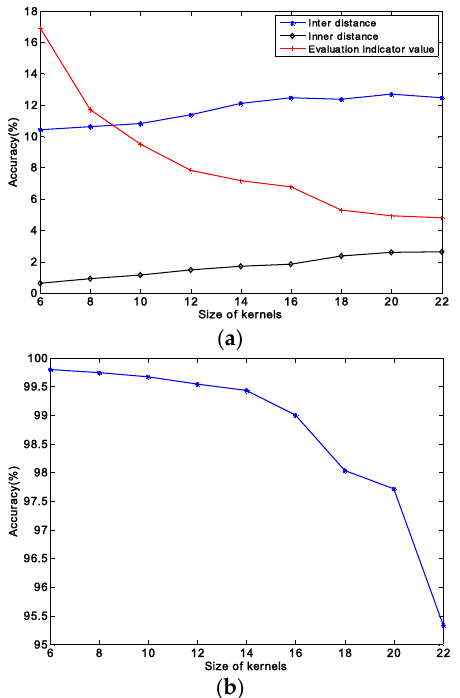
Figure 8. The classification accuracy influence with the kernel size. ( a ) the evaluation indicator value, the inter distance and inner distance with different kernel sizes on Dataset 1; ( b ) the classification accuracy with the evaluation indicator value on Dataset 1.